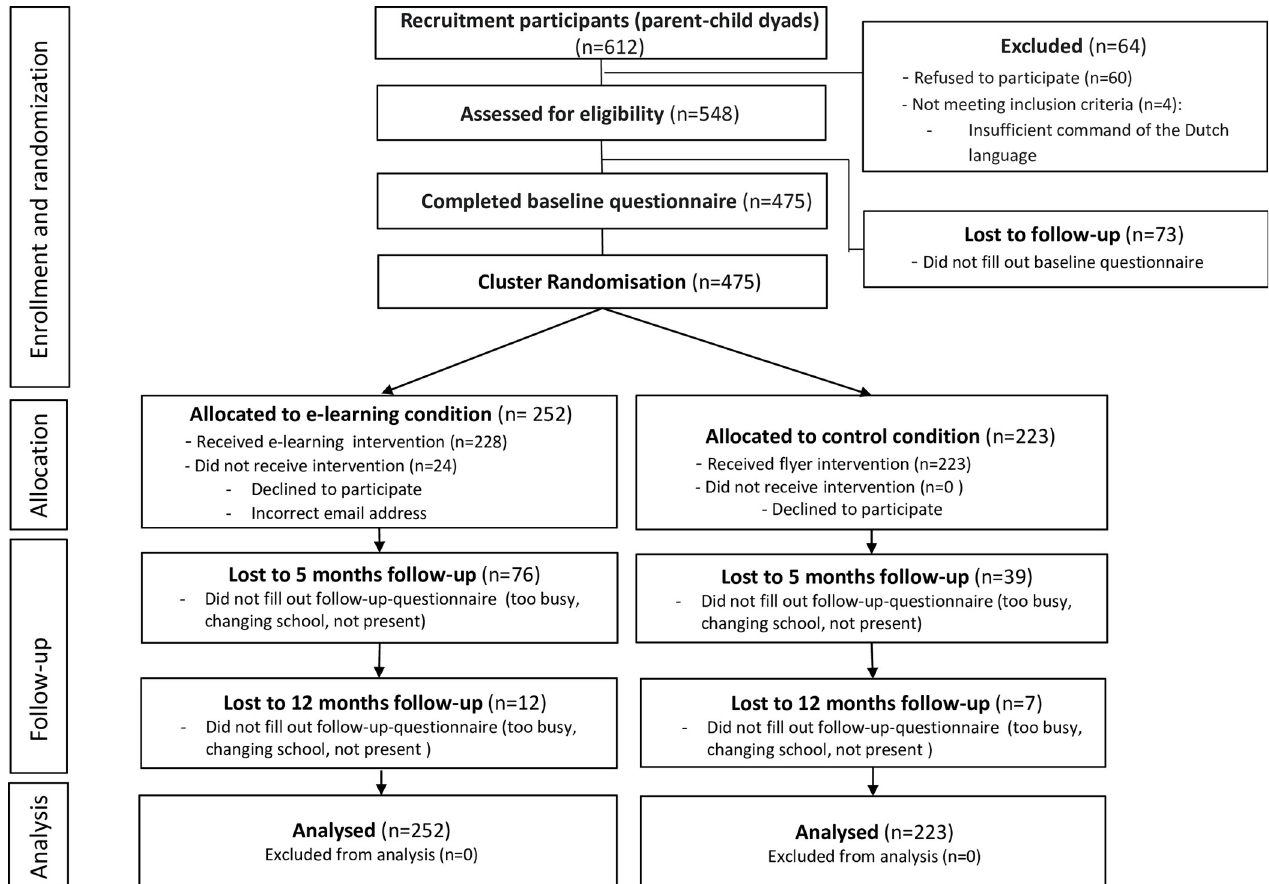
Fig 1. CONSORT flow diagram depicting the enrolment, allocation, follow-up, and analysis for the indicated number of parent-child dyads � . � In the completers-only framework, 164 and 177 parent-child dyads were analyzed in the intervention and control condition, respectively.